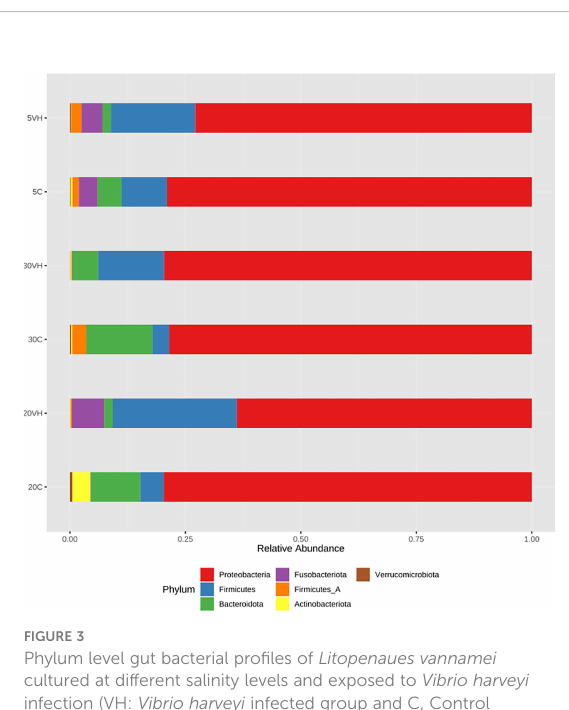
FIGURE 3 Phylum level gut bacterial pro fi les of Litopenaues vannamei cultured at different salinity levels and exposed to Vibrio harveyi infection (VH: Vibrio harveyi infected group and C, Control group; 5, 5 ppt; 20, 20 ppt and 30: 30